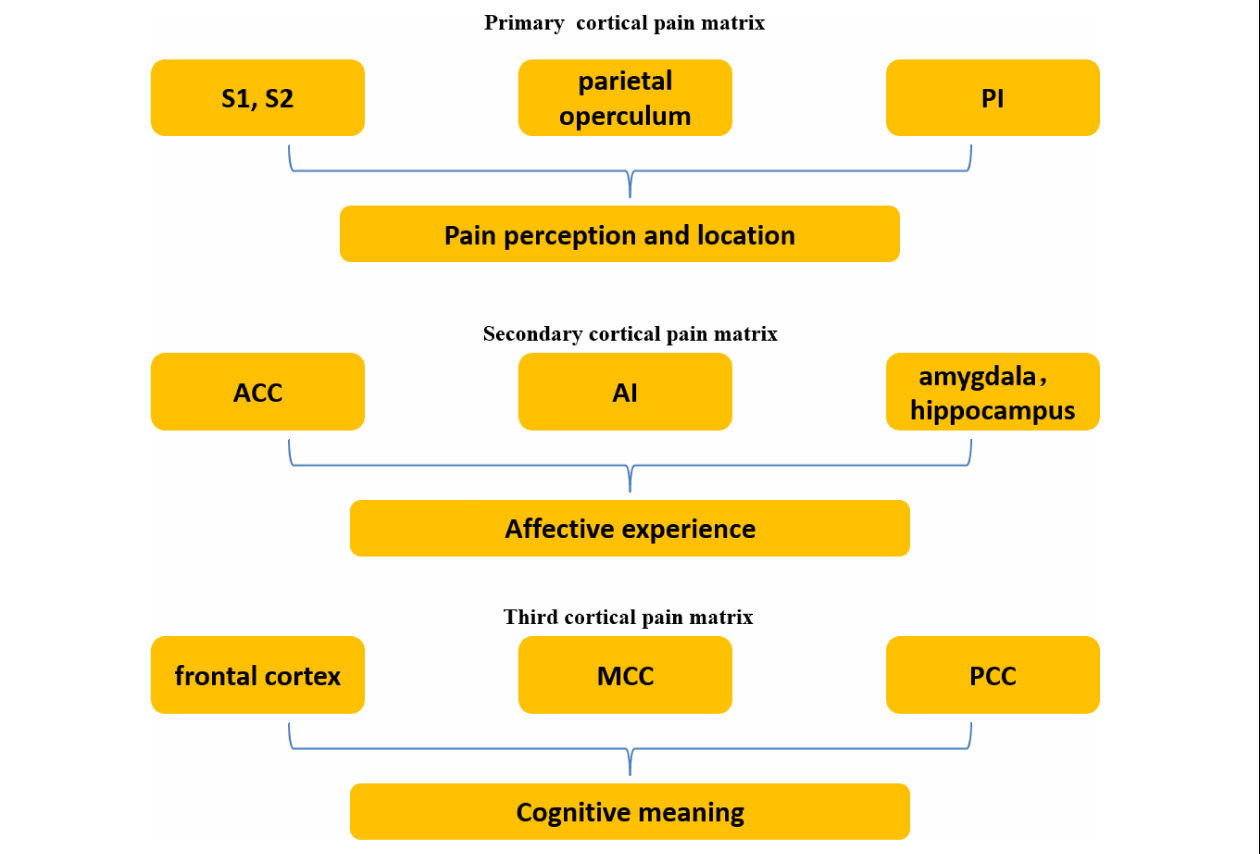
FIGURE 1 | Three levels of the pain matrix. The primary cortical pain matrix including primary and secondary somatosensory cortices (S1 and S2), parietal operculum, and posterior insula (PI) contributes to pain perception and location. The secondary including the anterior insula (AI), anterior cingulate cortex (ACC), hippocampus and amygdala functions in affect, which is associated with empathy for pain. The third including the frontal cortex and medial and posterior cingulate cortex (MCC and PCC) is associated with